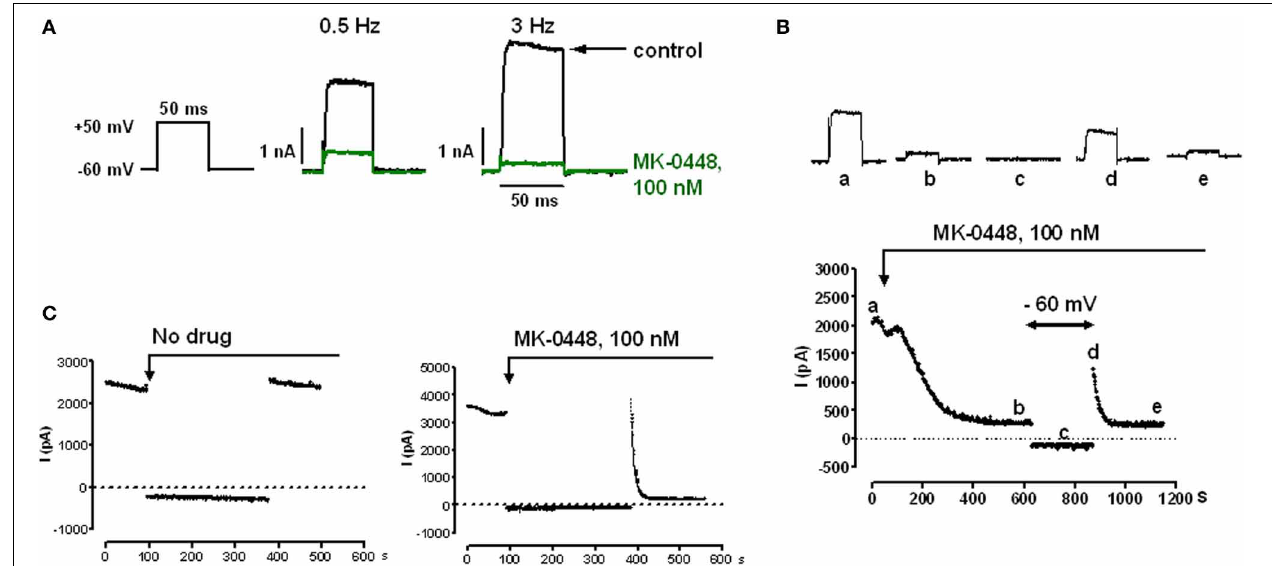
FIGURE 1 | Effects of MK-0448 on Kv1.5 currents measured in HK2BN9 cells at 25 ◦ C. (A) Voltage clamp and current traces obtained before (black) and after superfusion of cells with 100nM MK-0448 (green) for 10min. Rate of clamp pulses as indicated. (B) Onset of blocking effect of MK-0448 (100nM) on peak Kv1.5 current